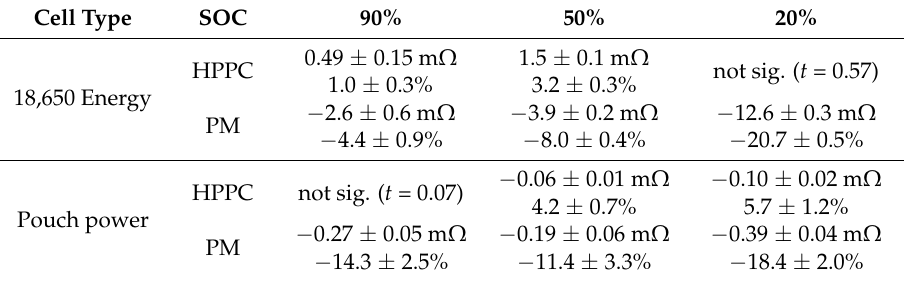
Table 4. Accelerated cell internal resistance difference a 25 ◦ C ambient.